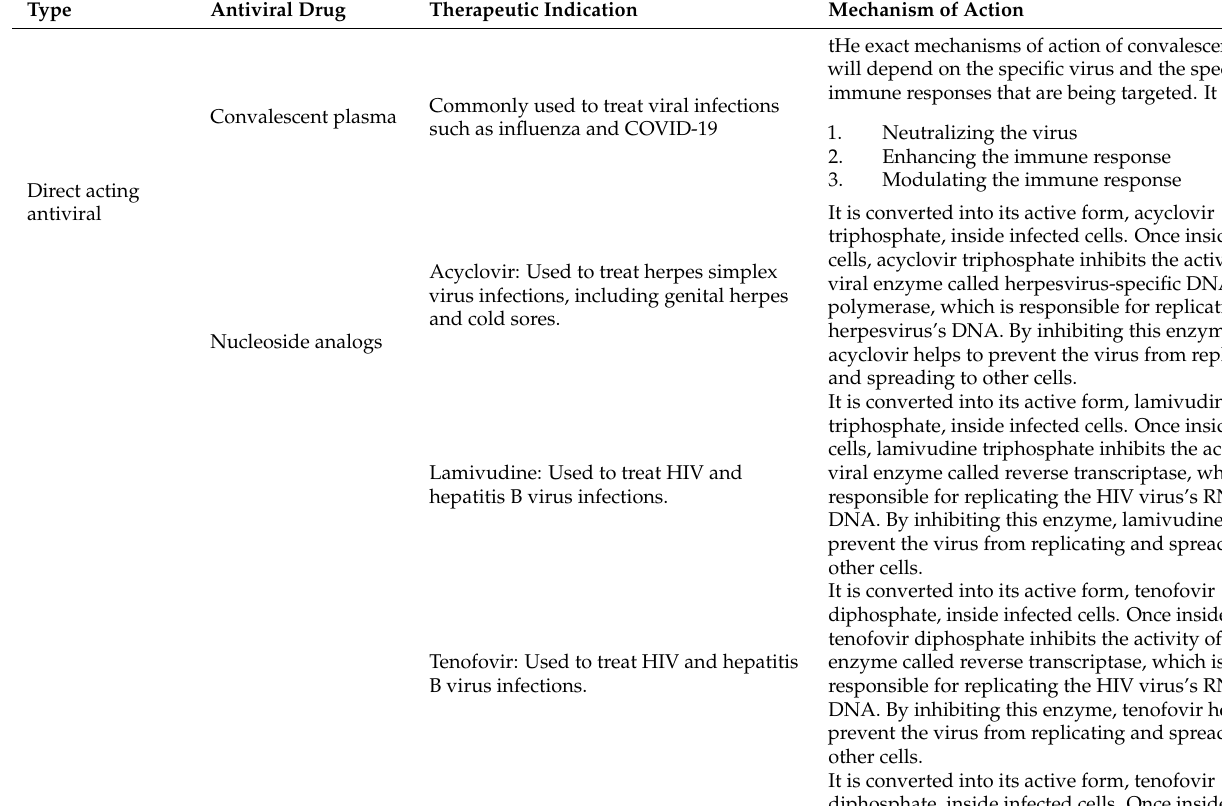
Table 1. Different types of antiviral drugs and treatments for viral